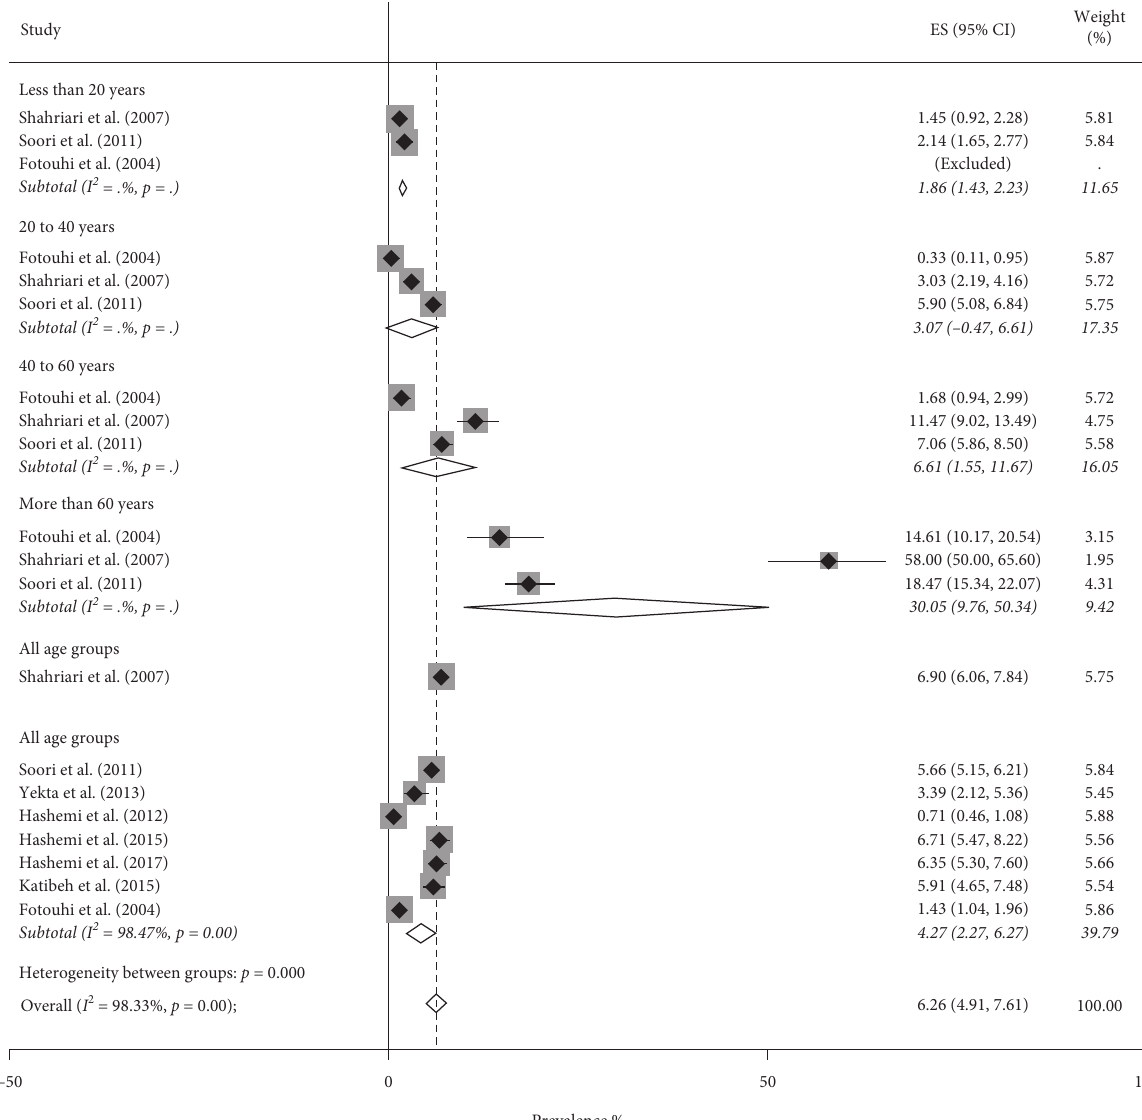
Figure 7: Forest plot of the prevalence of visual impairment among Iranian